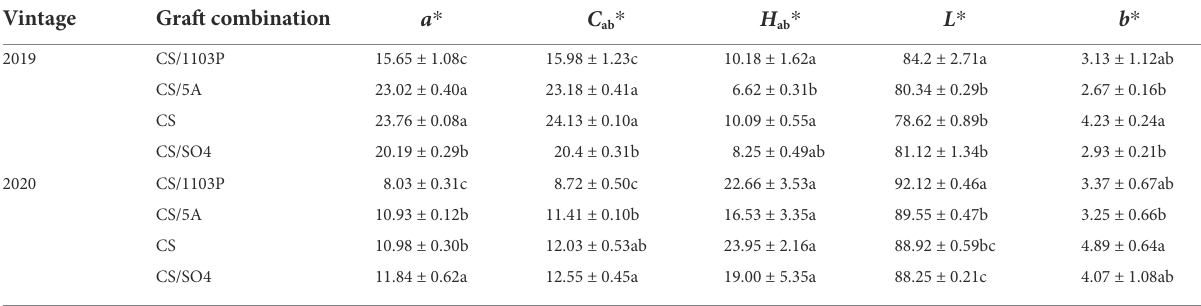
TABLE 3 Colorimetric parameters of Cabernet Sauvignon wines (clone 685) and three graft combinations (CS/1103P, CS/SO4, and CS/5A) during two growing seasons (2019–2020). Vintage